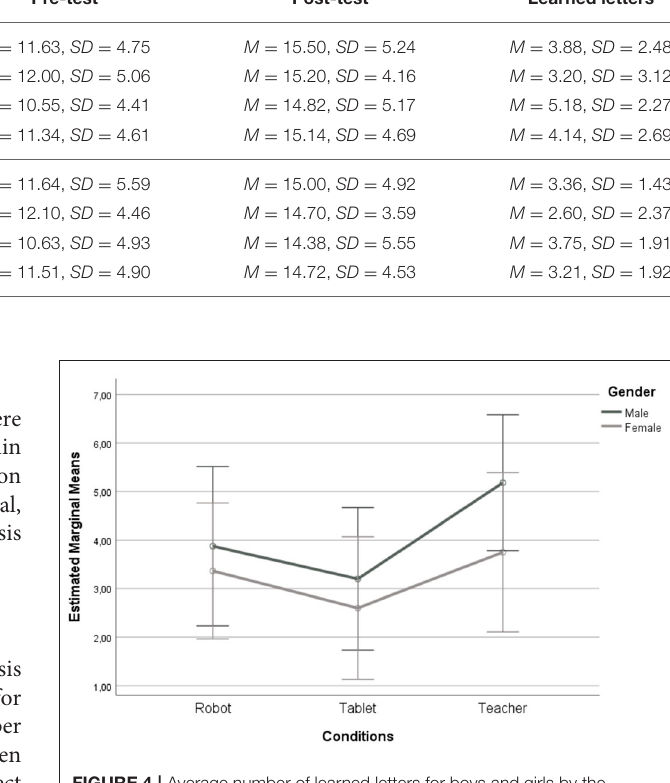
FIGURE 4 | Average number of learned letters for boys and girls by the conditions. Error bars show 95% Confidence